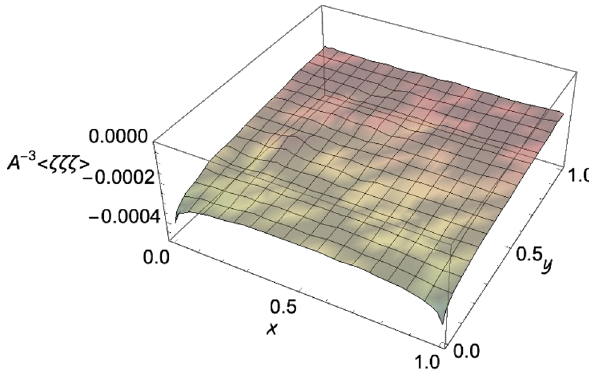
Figure 9 . A − 3 h δζ ( x 1 ) δζ ( x 2 ) δζ ( x 3 ) i fixing x 1 = (0 , 0) , x 2 = (1 , 0) (in arbitrary length unit) and varying x 3 in a